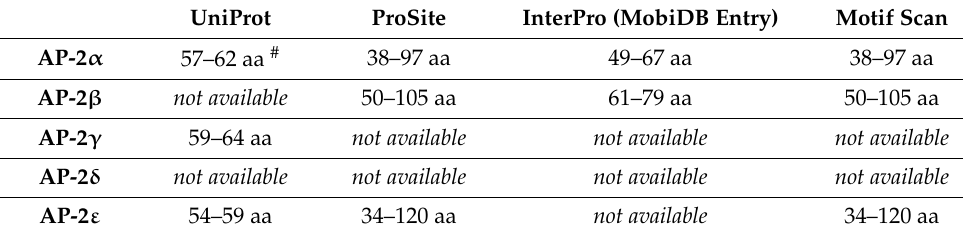
Table 1. Occurrence of proline-rich sequence in AP-2 transcription factors according to databases.